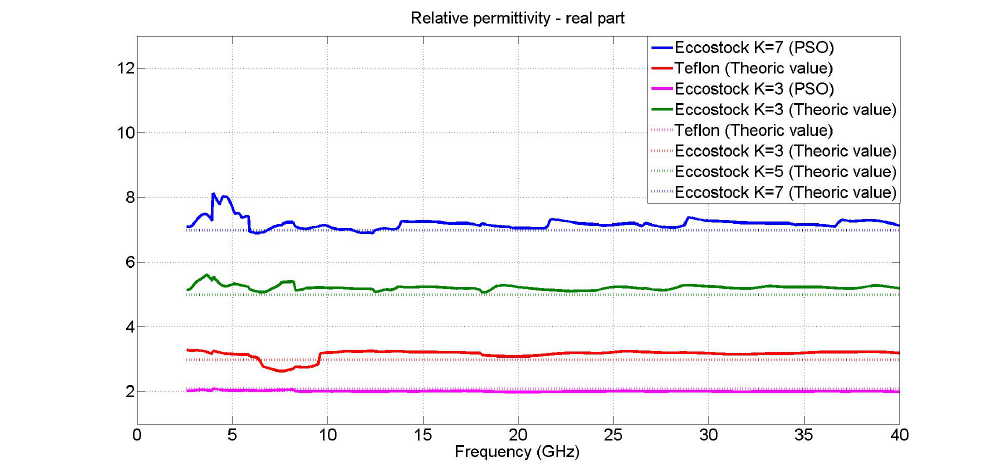
Figure 20. Comparison, from 2.6 to 40 GHz, between the values of the real part of the permittivity of Teflon and Eccostock (K = 3, K = 5 and K = 7), PSO and Theoric